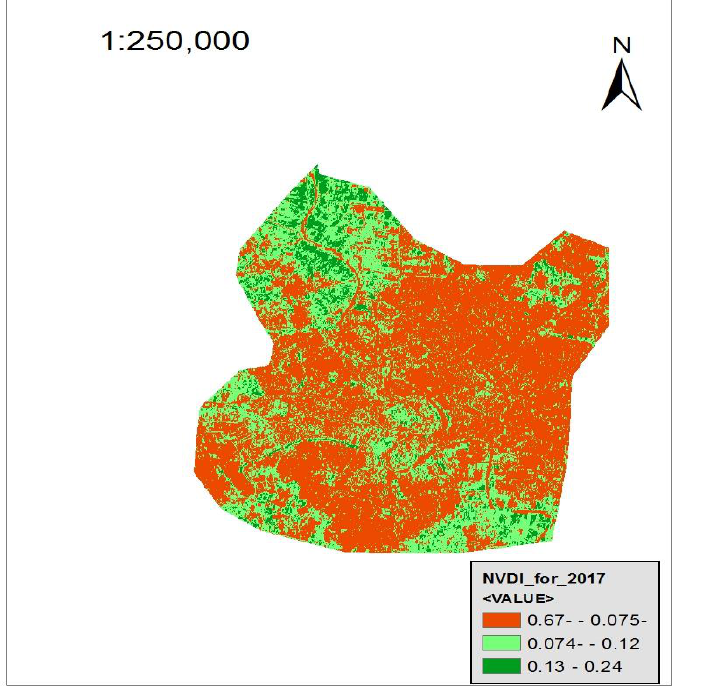
Fig.15: Show image NDVI for study area in date (27/11/2017).